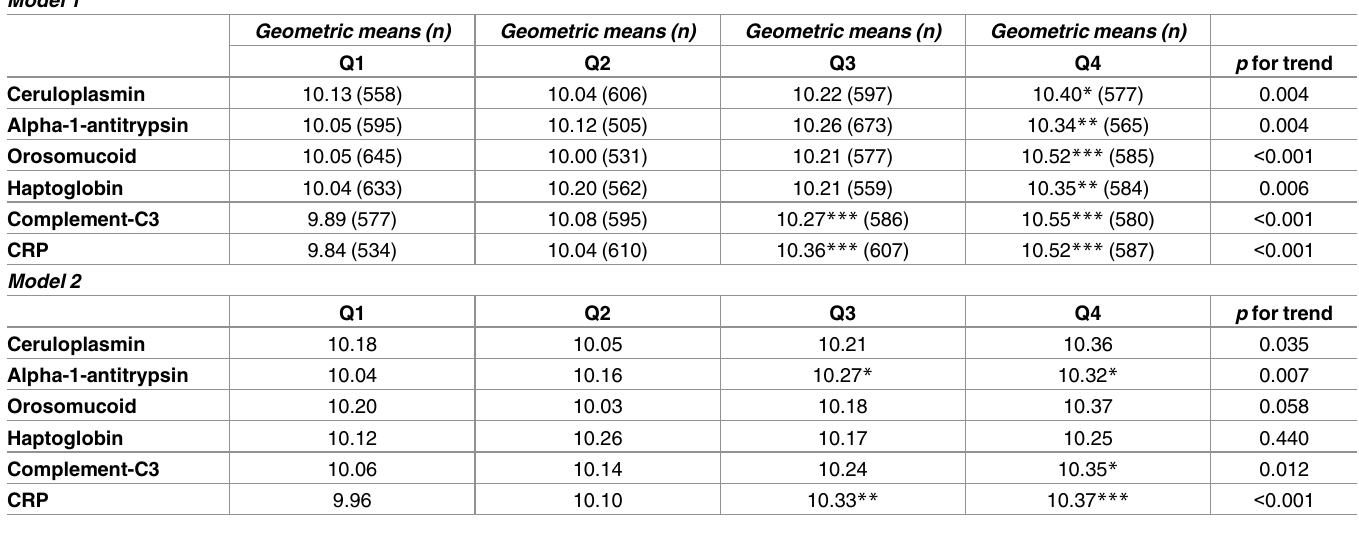
m/s vs 10.06 m/s) ( p < 0.05) and CRP (10.37 m/s vs 9.96 m/s) ( p < 0.001). The p -values for trend across quartiles of acute phase proteins are shown in Table 2. The interaction terms between sex and the acute phase proteins were not significant. Table 2. Relationships between the acute-phase proteins and c-f